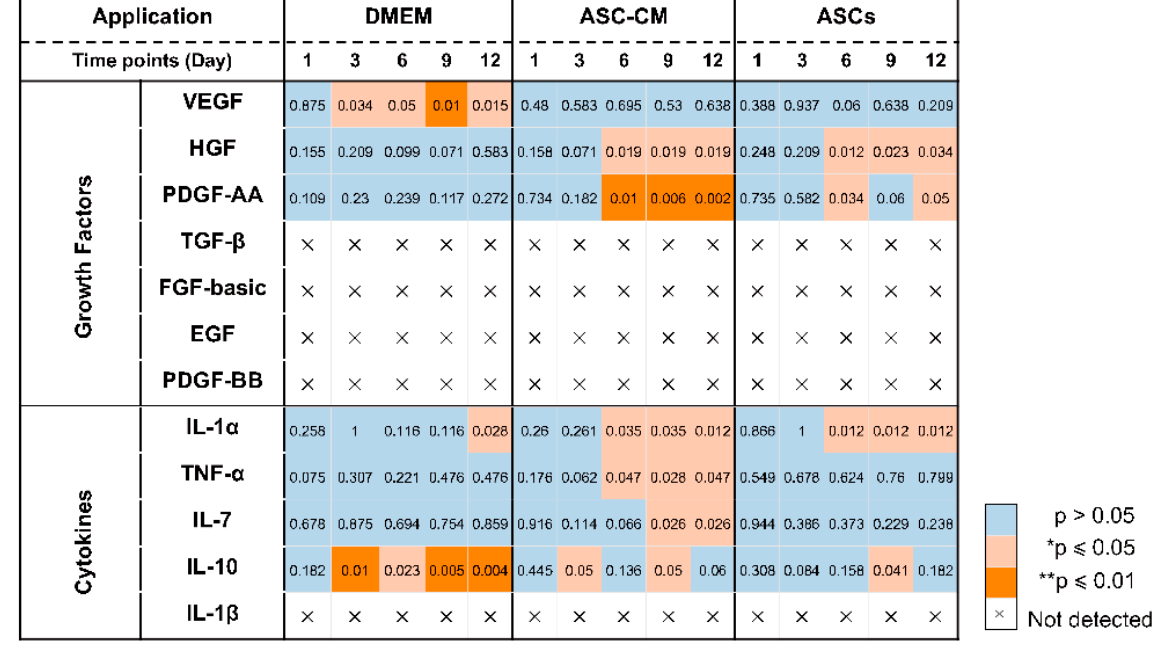
Figure 11. Visualization of statistically significant differences between treated samples and controls in wound culture